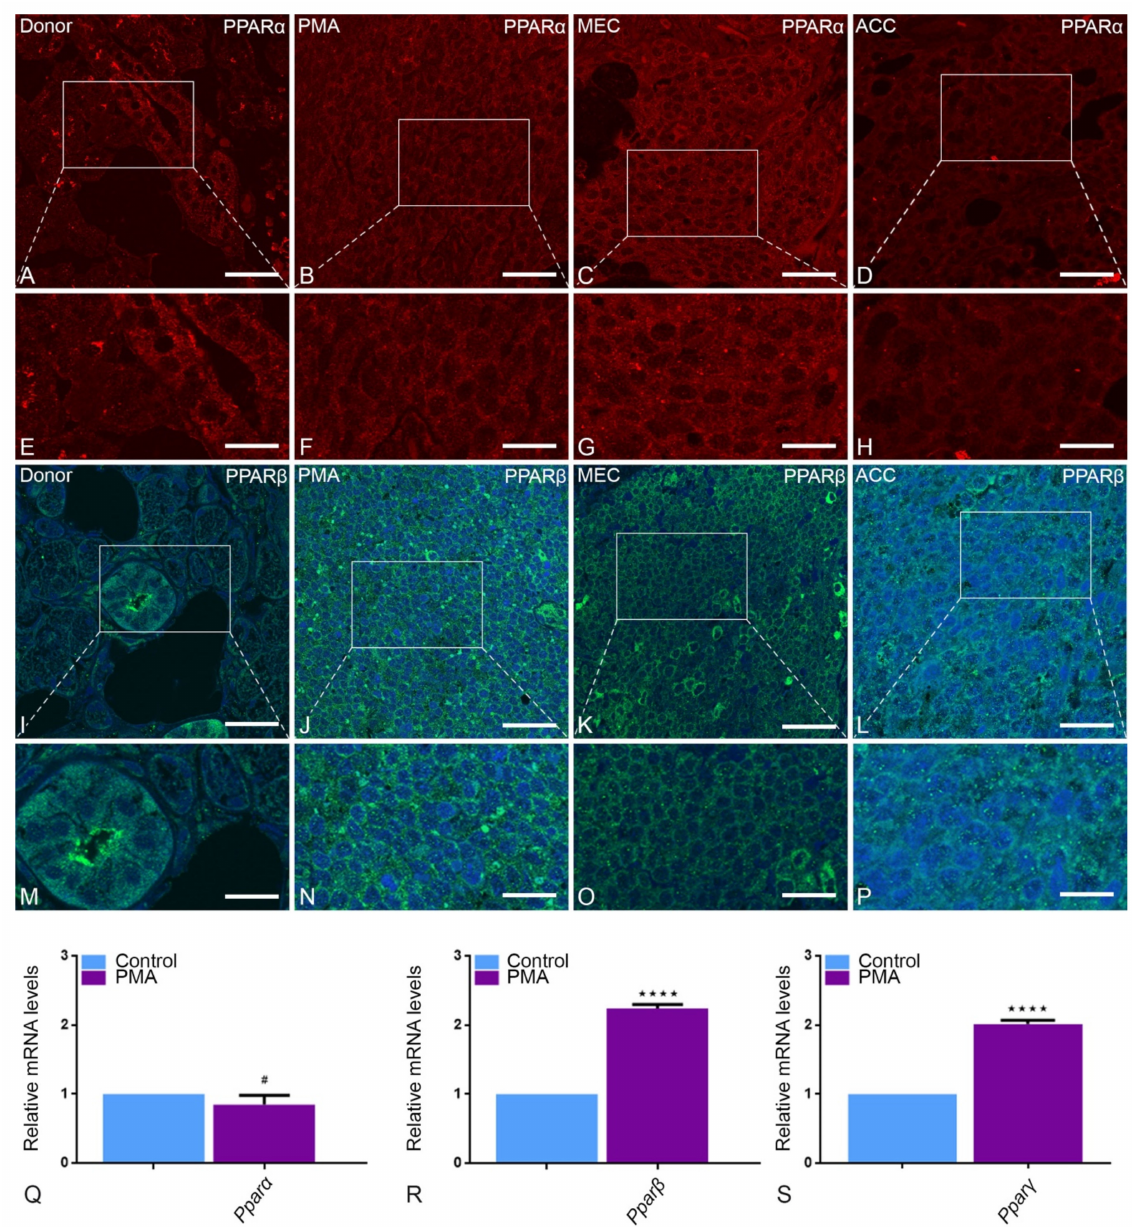
Figure 8. Peroxisomal proliferator-activated receptors in PMA, MEC and ACC: In healthy parotid tissue, a positive reaction of PPAR α ( A , E ) and PPAR β ( I , M ) can partially be observed, especially in striated duct cells. PPAR α staining is strong in PMA ( B , F ) and MEC ( C , G ) as also observed in the mRNA expression of PMA ( Q ). In contrast, ACC ( D , H ) shows less reaction compared to the two other tumor tissues. In IF, PPAR β is more abundant in PMA ( J , N ) and ACC ( L , P ) than in MEC ( K , O ). The high expression of Ppar β in PMA ( R ) can also be detected by real-time PCR analysis (**** p < 0.0001). Accordingly, the mRNA levels of Ppar γ are abundant in PMA (**** p < 0.0001) ( S ). Bars represent 50 µ m: ( A – D , I–L ); 18 µ m: ( E – H , M – P ). (Explanation of the notations: The number of asterices signifies the degree of significance of the p -value, while # means not